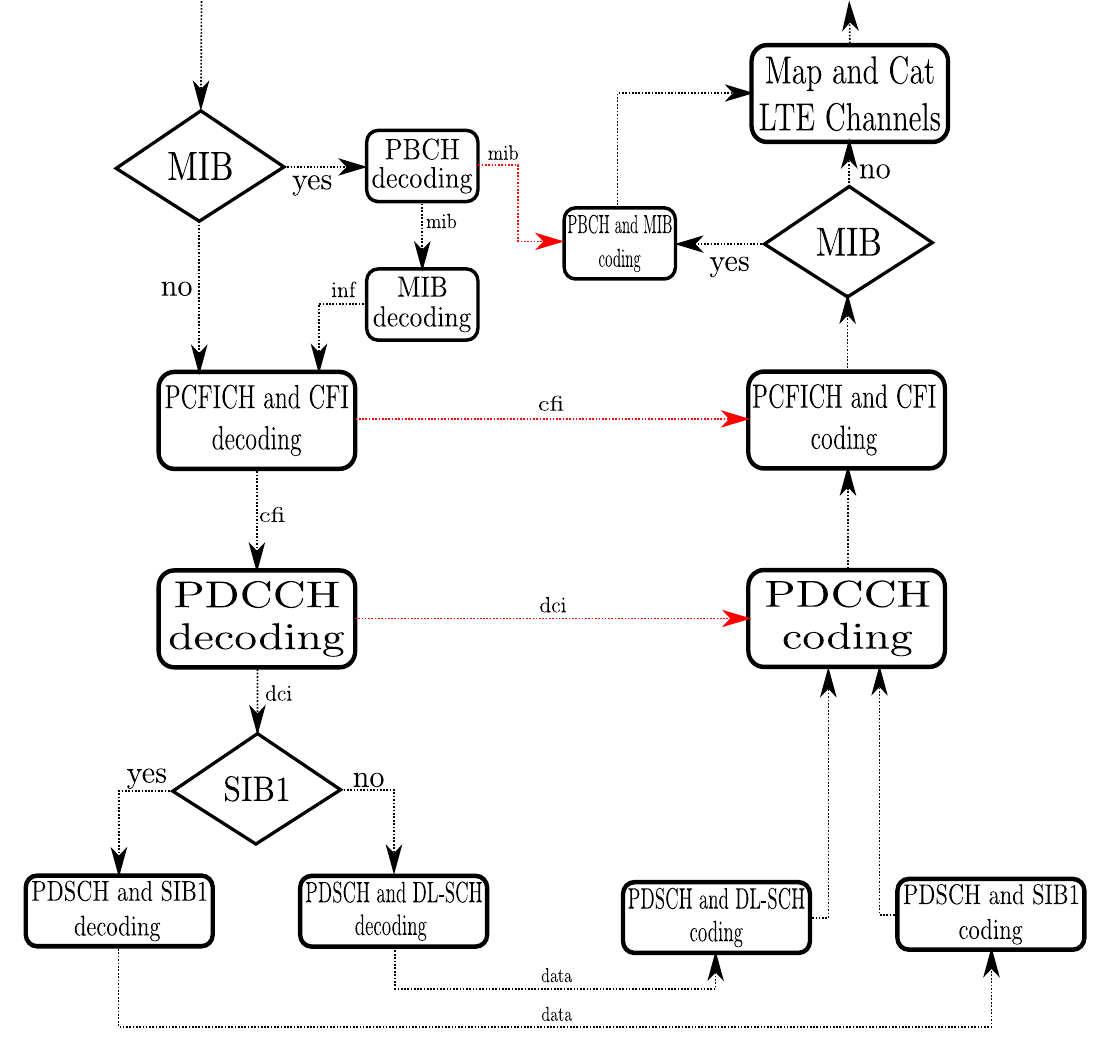
Figure 10. Demodulation-&-Modulation Algorithm Processing